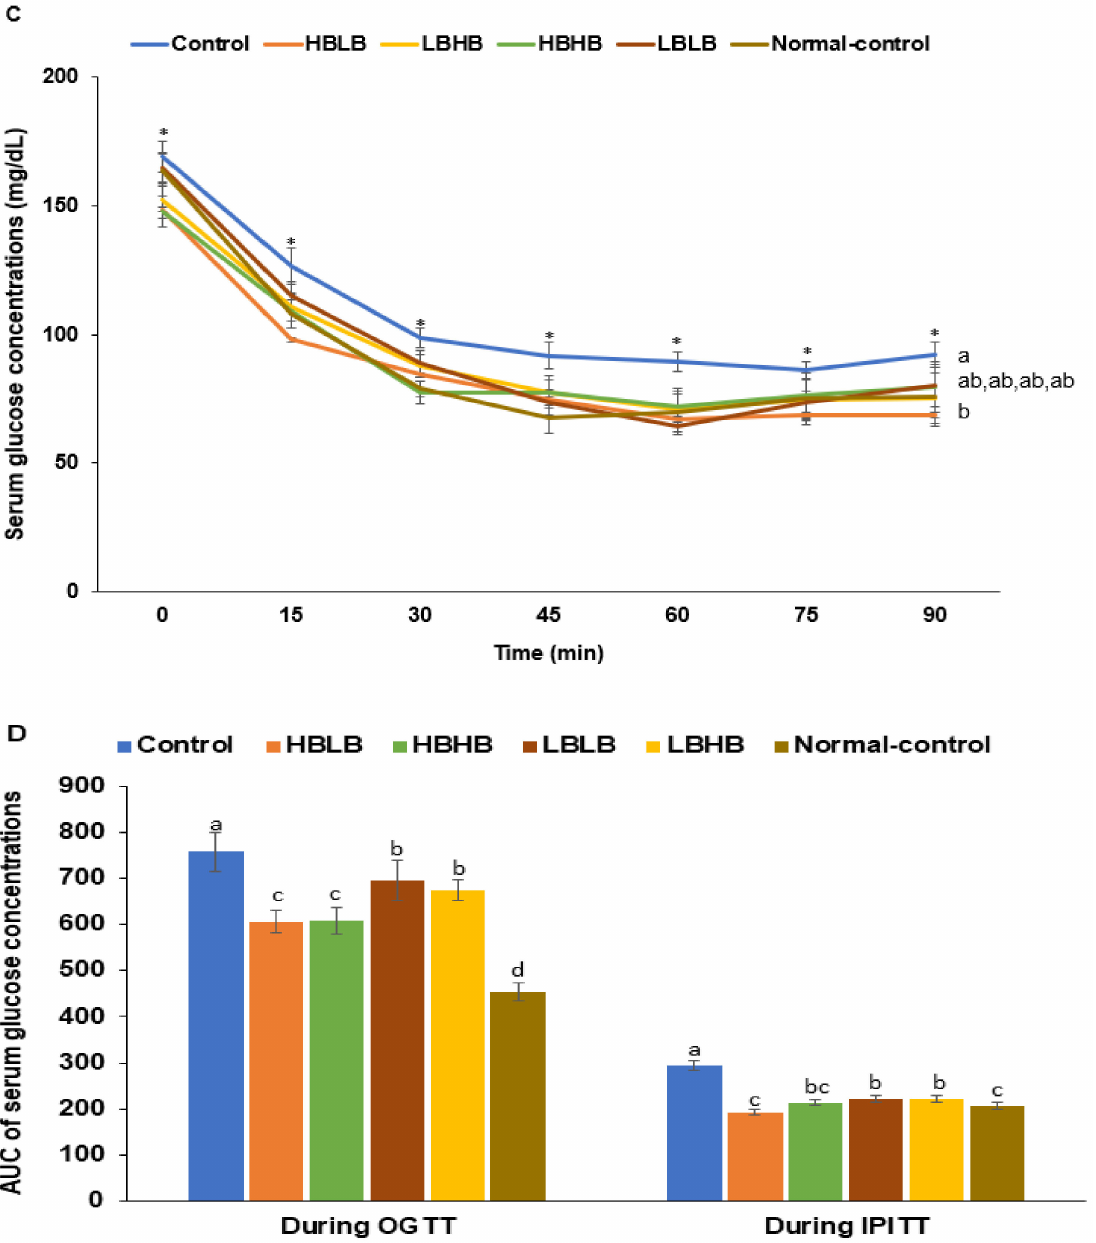
Figure 4. Serum glucose concentrations during oral glucose tolerance (OGTT) and intraperitoneal insulin tolerance test (IPITT). ( A ). Changes in serum glucose concentrations after oral intake of 2 g glucose per kg body weight during OGTT. ( B ). Changes in serum insulin concentration during IPITT. ( C ). Changes in serum glucose concentration after intraperitoneal injection of 1 U insulin per kg body weight. ( D ). The area under the curve of serum glucose concentration during OGTT and IPITT. Dots or bars and error bars represent the means ± standard deviations ( n = 10). HBLB, the rats fed TMK with high contents of Bacillus spp. and high biogenic amines; HBHB, the rats fed TMK with high contents of Bacillus spp. and low biogenic amines; LBHB, the rats fed TMK with low contents of Bacillus spp. and high biogenic amines; LBLB, the rats fed TMK with low contents of Bacillus spp. and low biogenic amines. OGTT, oral glucose tolerance test; IPITT, intraperitoneal insulin tolerance test. * Significantly different among the groups at p < 0.05. a–d Different letters on the bars indicated a significant difference among the groups by Tukey test at p <